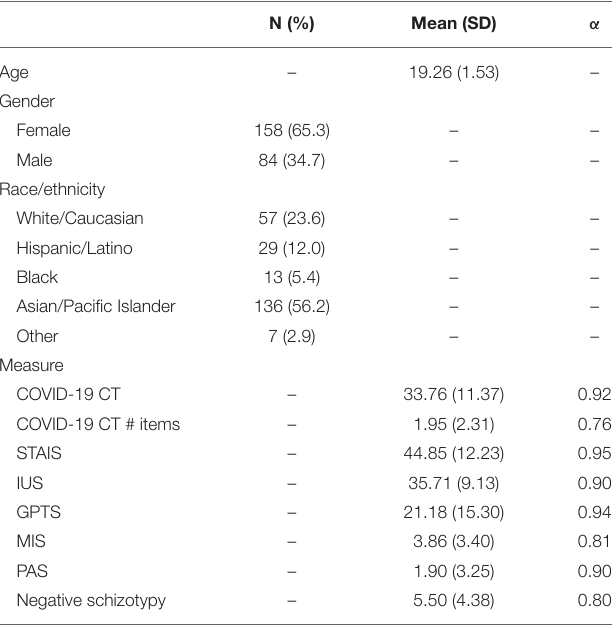
TABLE 2 | Demographics and questionnaire descriptives for Study 2. Supplementary Table 2 ). Skewness values > 1.0: were observed for PAS (1.91) and Negative schizotypy (1.11); thus Spearman